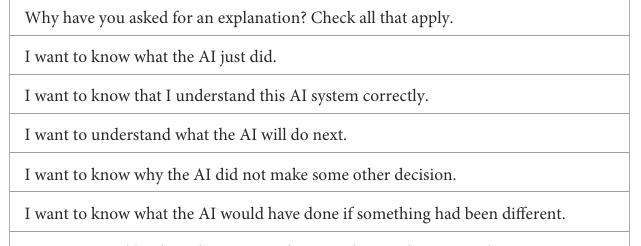
refers to the workings of computational devices, rather than daily life or